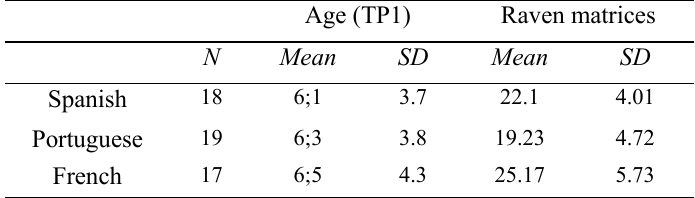
Table I: Characteristics of the Spanish, Portuguese, and French speaking children. Age